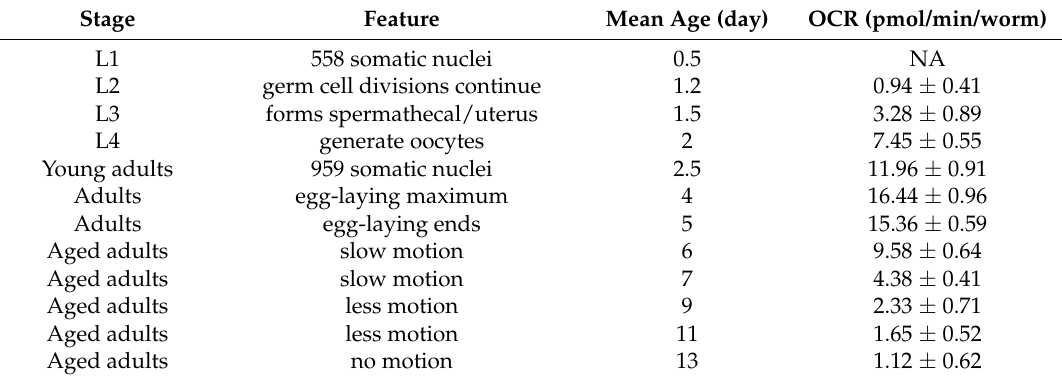
Table 1. Developmental stages of wild-type N 2 worms used for